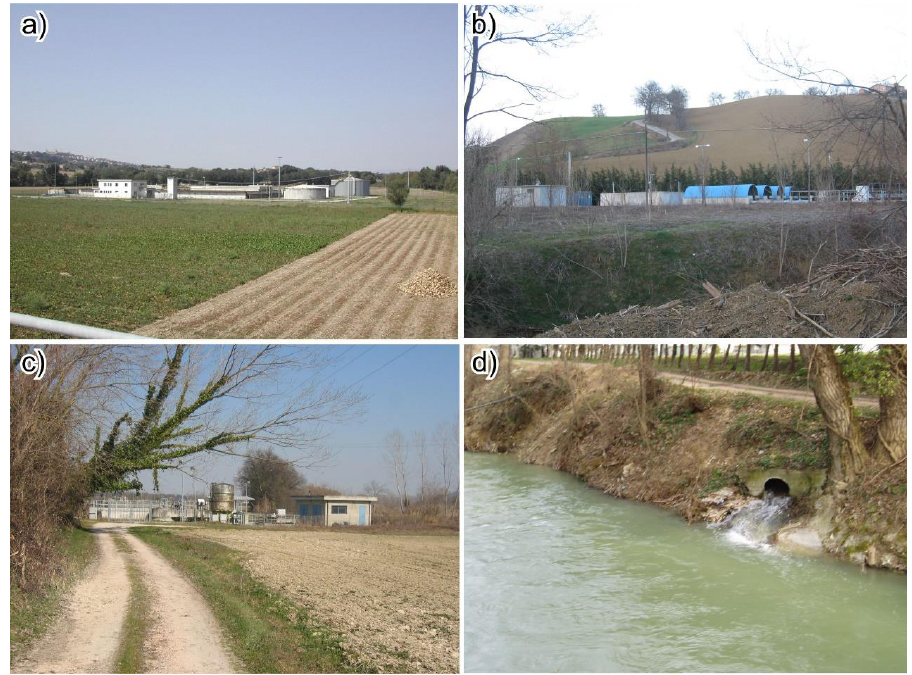
Figure 3. ( a – c ) the wastewater treatment plants of Tolentino, Camerino and Servigliano, respectively; ( d ) typical waste collector present along the riverbeds in correspondence of the main plants.